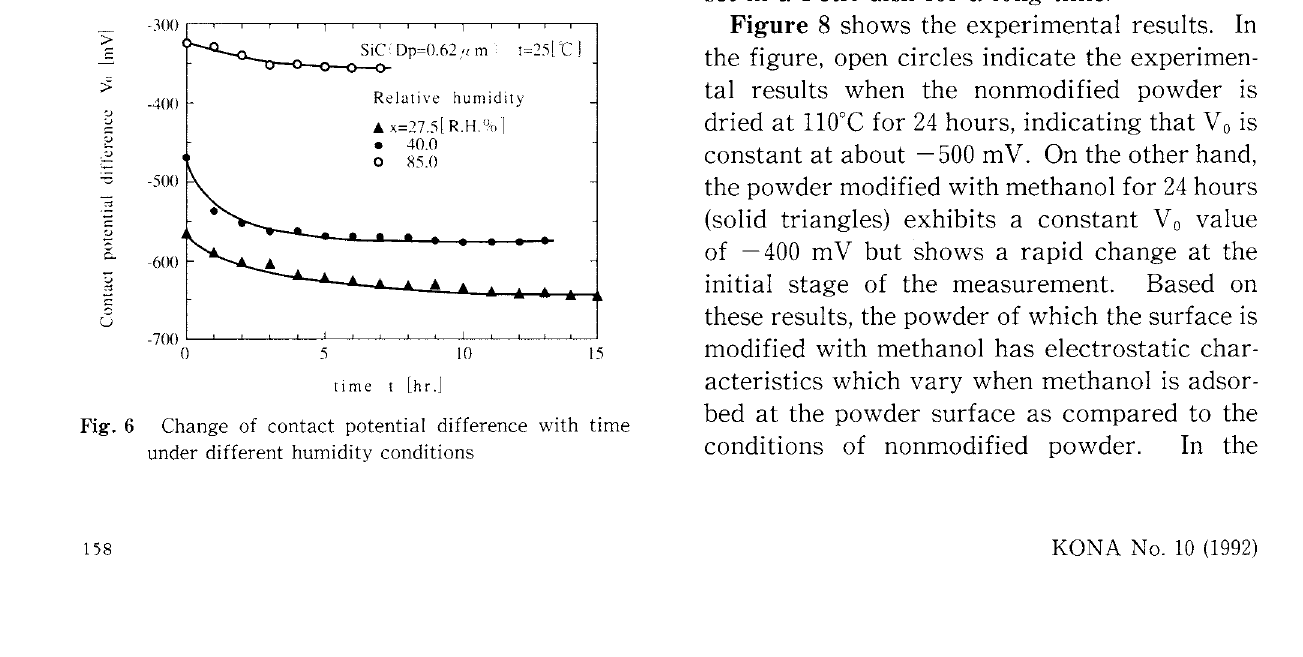
Fig. 6 Change of contact potential difference with time